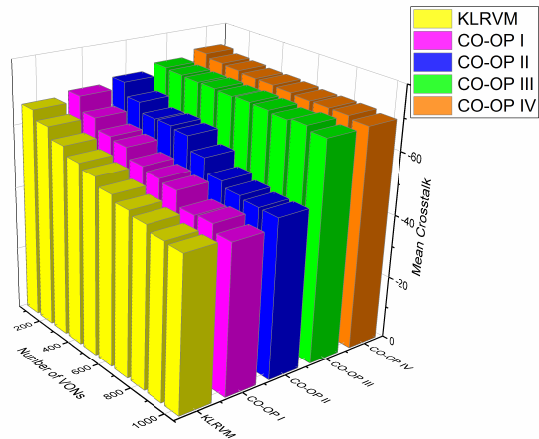
Figure 10. Mean crosstalk for the NSFNET topology.